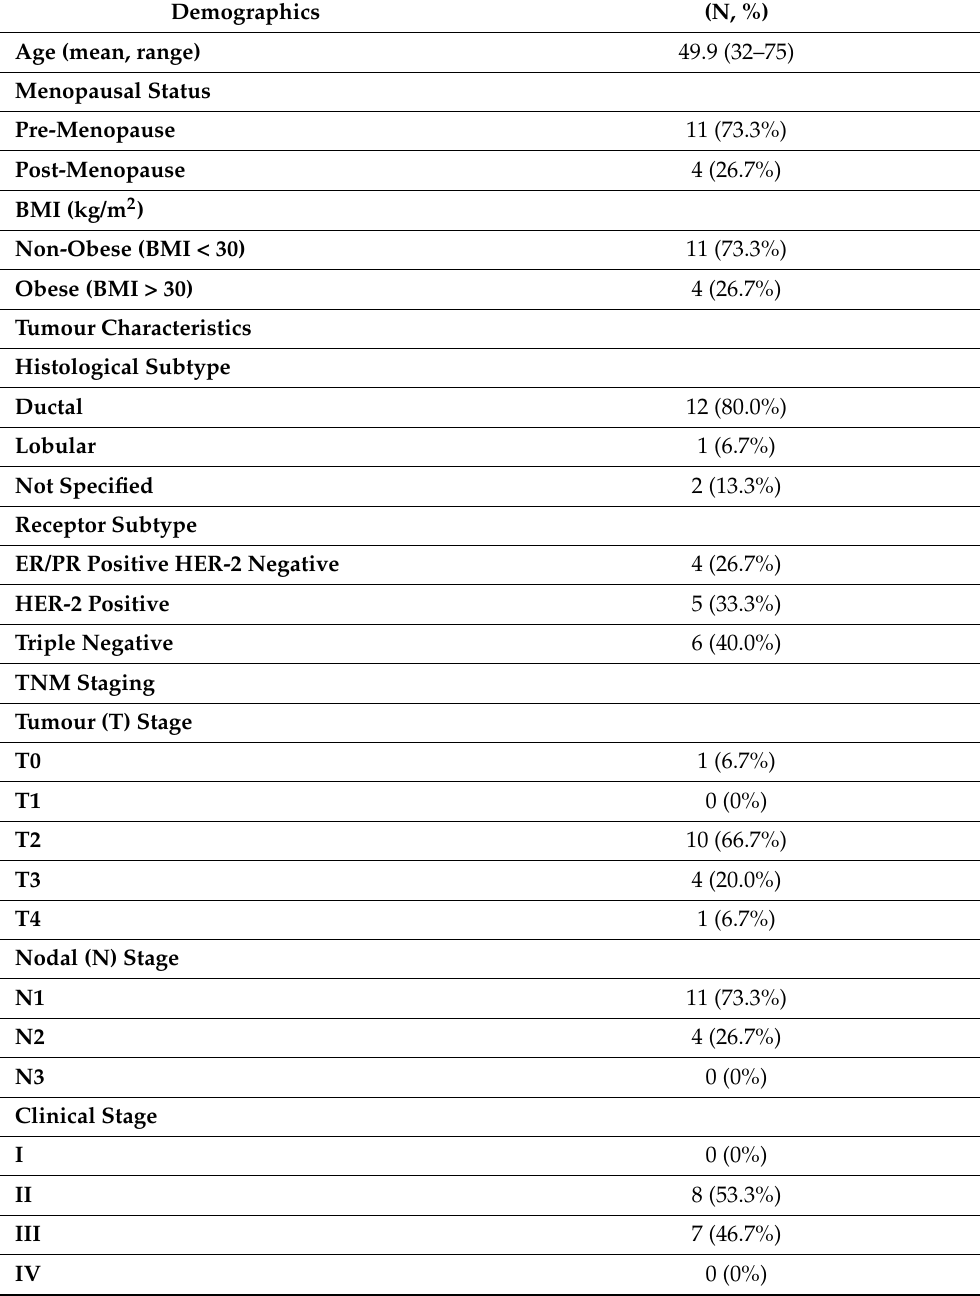
Table 1. Patient